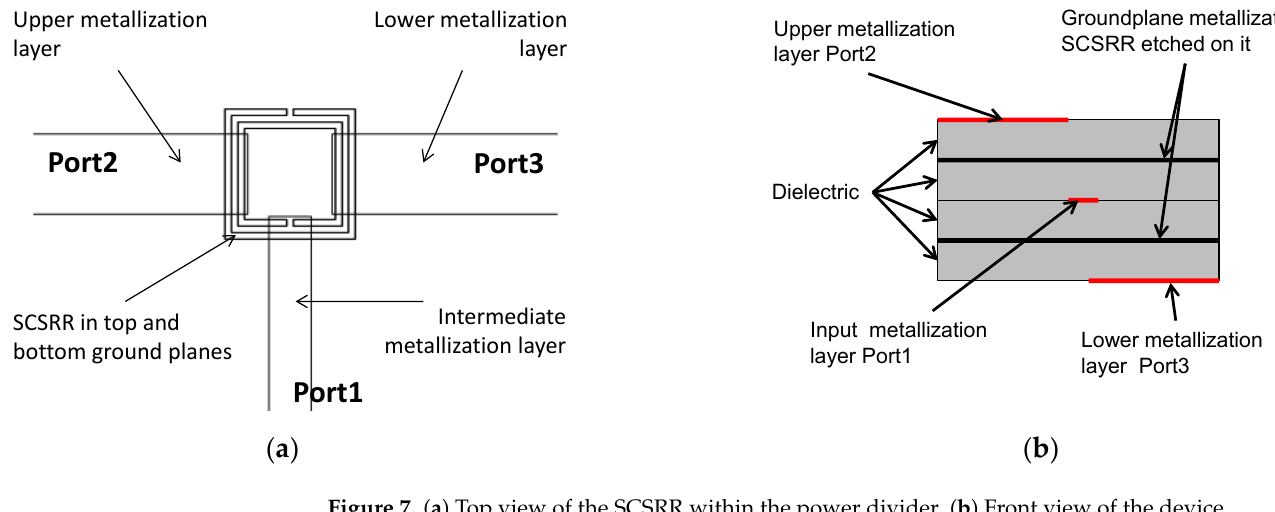
Figure 8. Detailed top view and relevant dimensions.